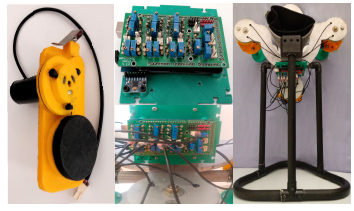
Figure 31. Assembled